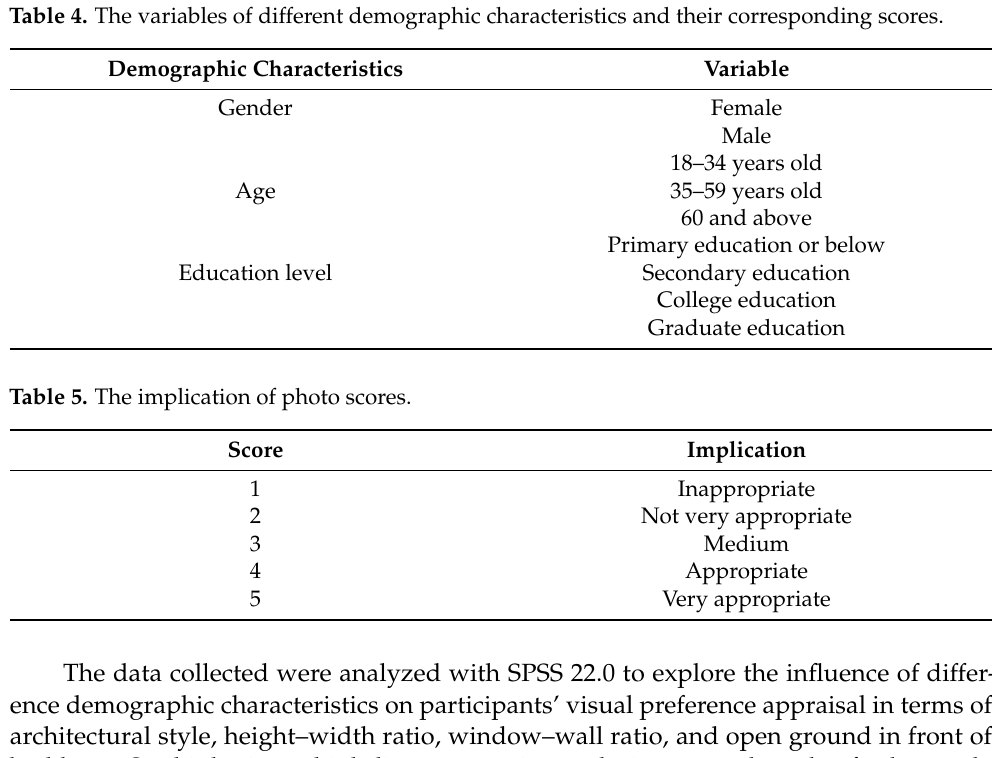
Table 4. The variables of different demographic characteristics and their corresponding scores.